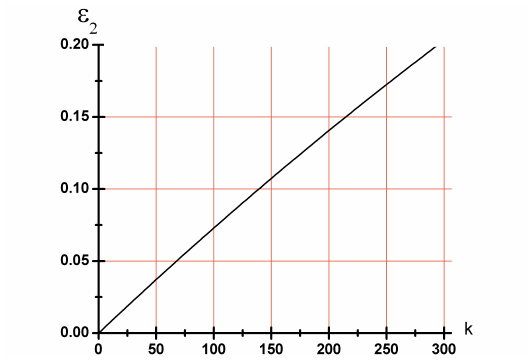
Figure 1. The error rate of Protocol 2 changing with the size of